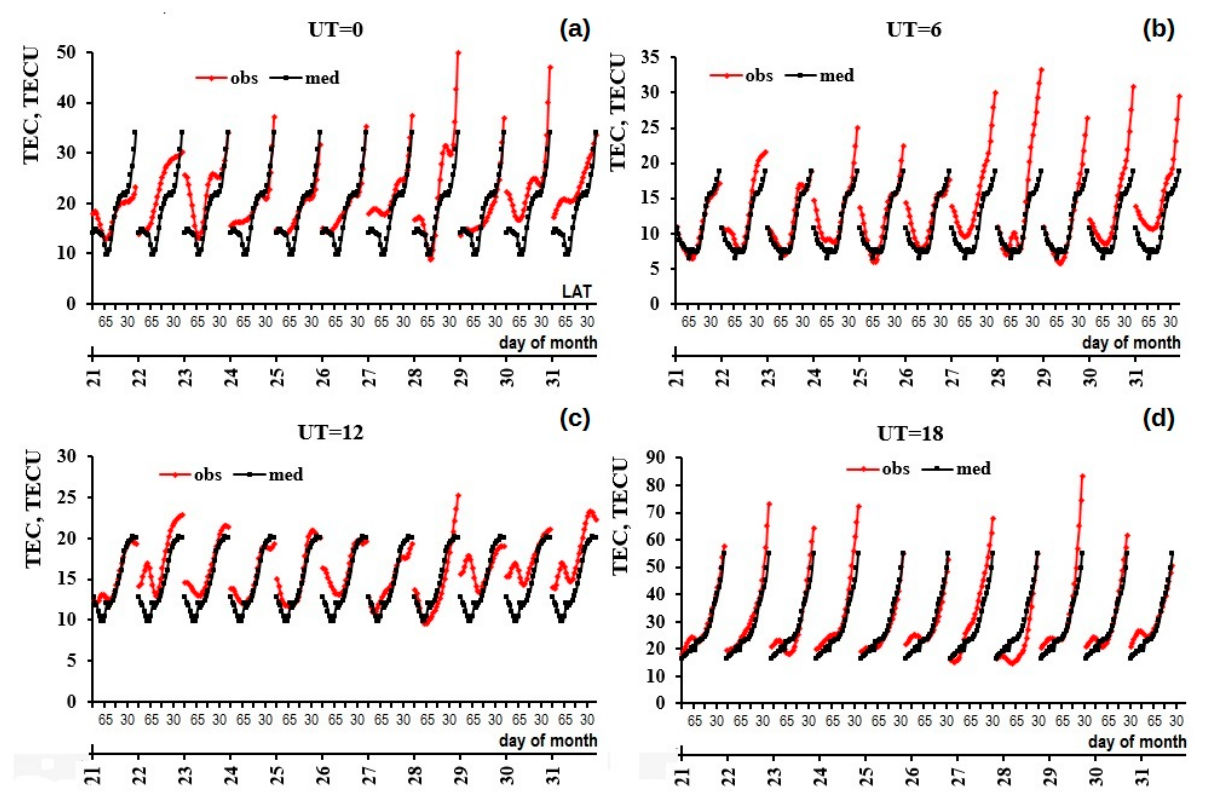
Figure 6. The same as in Figure 5 but during 21–31 March 2012.